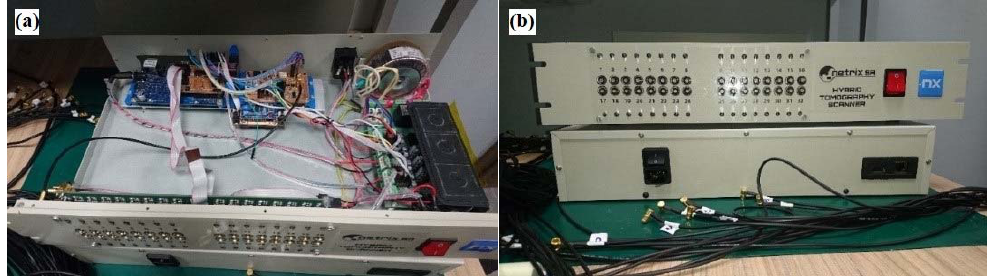
Figure 4. The measurement device. ( a ) inside view, ( b ) main panel view.